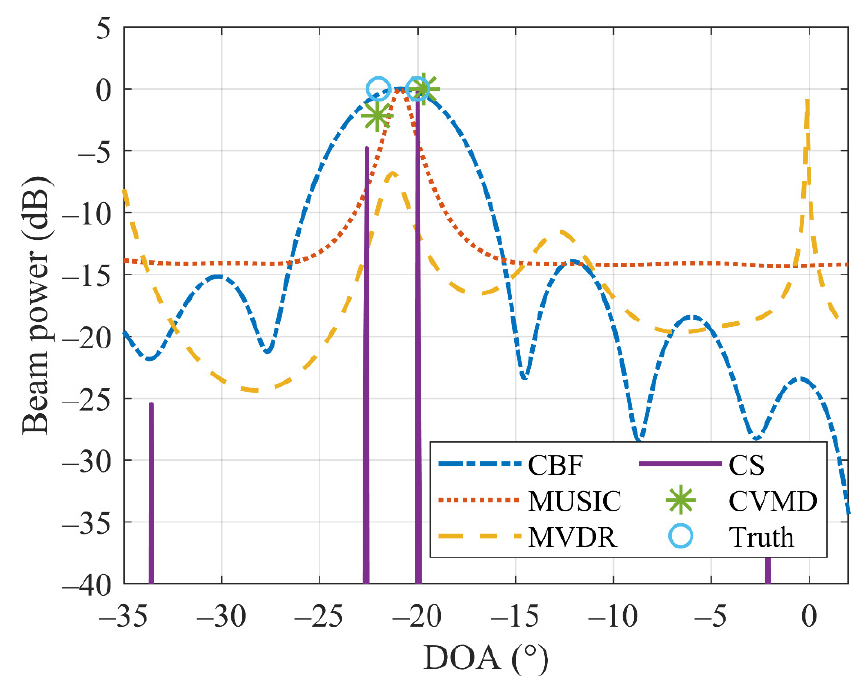
Figure 2. DOA estimation for two equal strength coherent sources at 20° and 22° by CBF, MUSIC, MVDR, CS, and CVMD method.